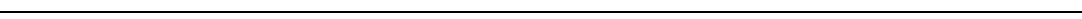
Fig. 3 Predicted connectivity along dendrites. a Two neurons are mutually connected: the synapses are randomly distributed across the basal dendrites and both neurons are activated by generating Poisson spike trains and injecting a brief external current into the somatic compartments at the relevant spike times. b The mean distance of the synapses to the soma is negatively correlated to the number of strengthened synapses (Pearson ’ s r = − 0.569, p < 2e − 3). c , d Two examples of the fi nal connectivity. Colour codes can be found at the legend on top of the fi gure. e Same as panel a , but the synapses are now constraint to either proximal or distal compartments. f More synapses are strengthened when targeting proximal regions compared to when targeting distal regions. The stacked bars show the means over fi ve simulations ( error bars indicate one s.d.). g , h Examples of fi nal connectivity for the proximally distributed case g and the distally distributed case h . i Analogous to panel e , but synapses are clustered onto one proximal or distal compartment. j Analogous to panel f , but synapses are now clustered onto one proximal or distal compartment. By comparing with f , proximal synapses are less in fl uenced by the clustering than distal synapses. The stacked bars show the means over fi ve simulations ( error bars indicate one s.d.). k , l Examples of the fi nal connectivity for the proximally clustered case k and the distally clustered case l . m We divide our basal dendritic tree in nine regions depending on the distance from the soma. For each distance range, synapses are either randomly distributed among the relevant compartments, or clustered on one of the compartments. n The mean results of connectivities for the distributed and the clustered simulations in each distance range are summed. The values are multiplied by the number of compartments in the respective distance range. o Neuron 1 is always activated before neuron 2. The synapses are clustered either proximally or distally. p In the proximal case, all simulations result in unidirectional connections from neuron 1 to neuron 2. In the distal case, only bidirectional connections are observed. q , r Examples of the evolution of the mean synaptic weights during the simulation in the proximal case q and the distal case